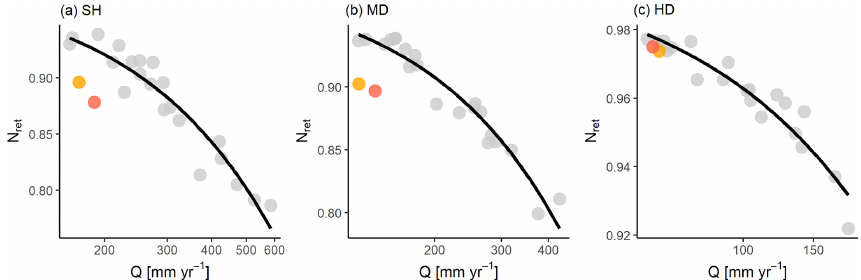
Figure 6. Relationship between the N retention capacity of catchments (N ret ) and log-scaled discharge ( Q ) at the nested catchment scale, given as annual averages (12-month period starting in May). Black lines represent the non-linear relationship between Nret and discharge ( Q ) prior to the 2-year drought (1997–2017), with log-transformed x